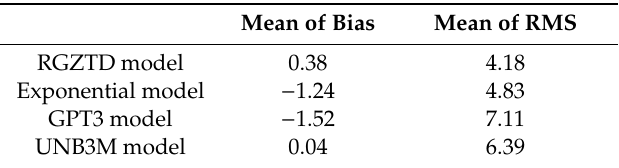
Table 1. Mean bias and RMS of RGZTD model, Exponential model, GPT3 model and UNB3M model with respect to ERA5 ZTD data in 2017–2018 [cm].